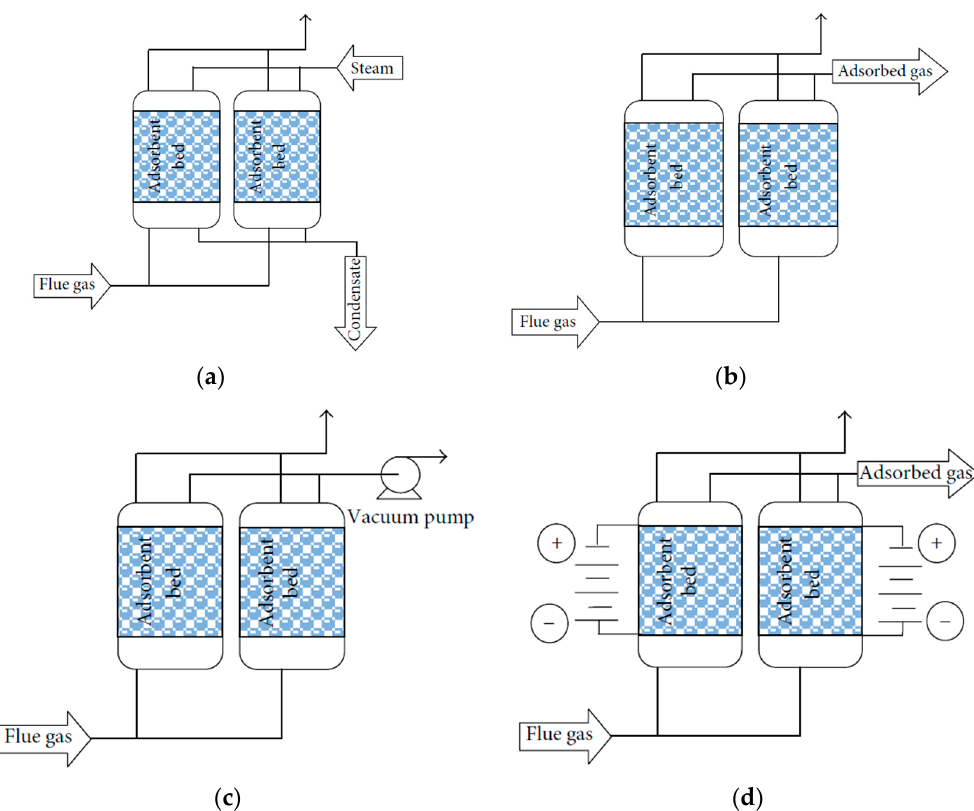
Figure 8. Schematic diagram of different adsorption regeneration cycles: ( a ) TSA ( b ) PSA ( c ) VSA ( d ) ESA [57].